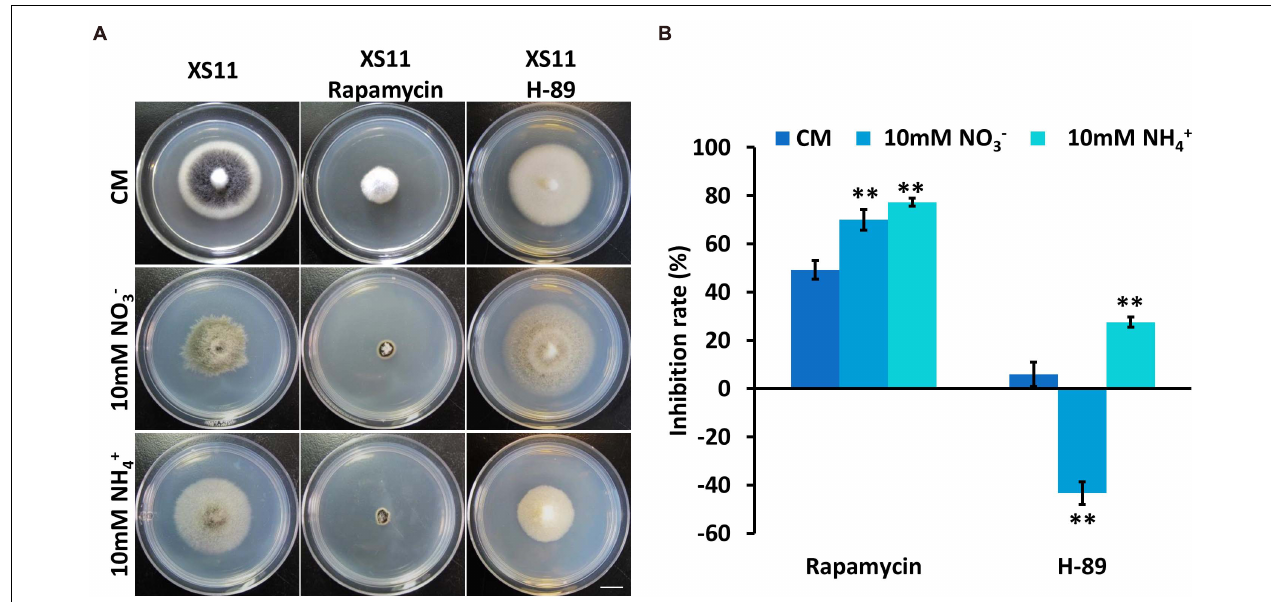
FIGURE 6 | Responses of Verticillium dahliae to rapamycin and H-89 when utilizing two different nitrogen sources. (A) The XS11 strain was grown for 10 days on CM and on defined minimal media containing 1% (w/v) glucose (GMM) with 10 mM of the indicated sole nitrogen source including NO 3 − and NH 4 + , and with 10 µ M rapamycin and 40 µ M N -[2-( p -Bromocinnamylamino)ethyl]-5-isoquinolinesulfonamide · 2HCl hydrate (H-89) at 25 o C. Photographs were taken at 10 days post inoculation (dpi) of the media. Scale = 1.05 cm. (B) The chart illustrates the inhibition rates of the above colonies at 10 dpi. Error bars represent the standard deviation based on three independent replicates. Asterisks indicate significant differences ( ∗∗ P <